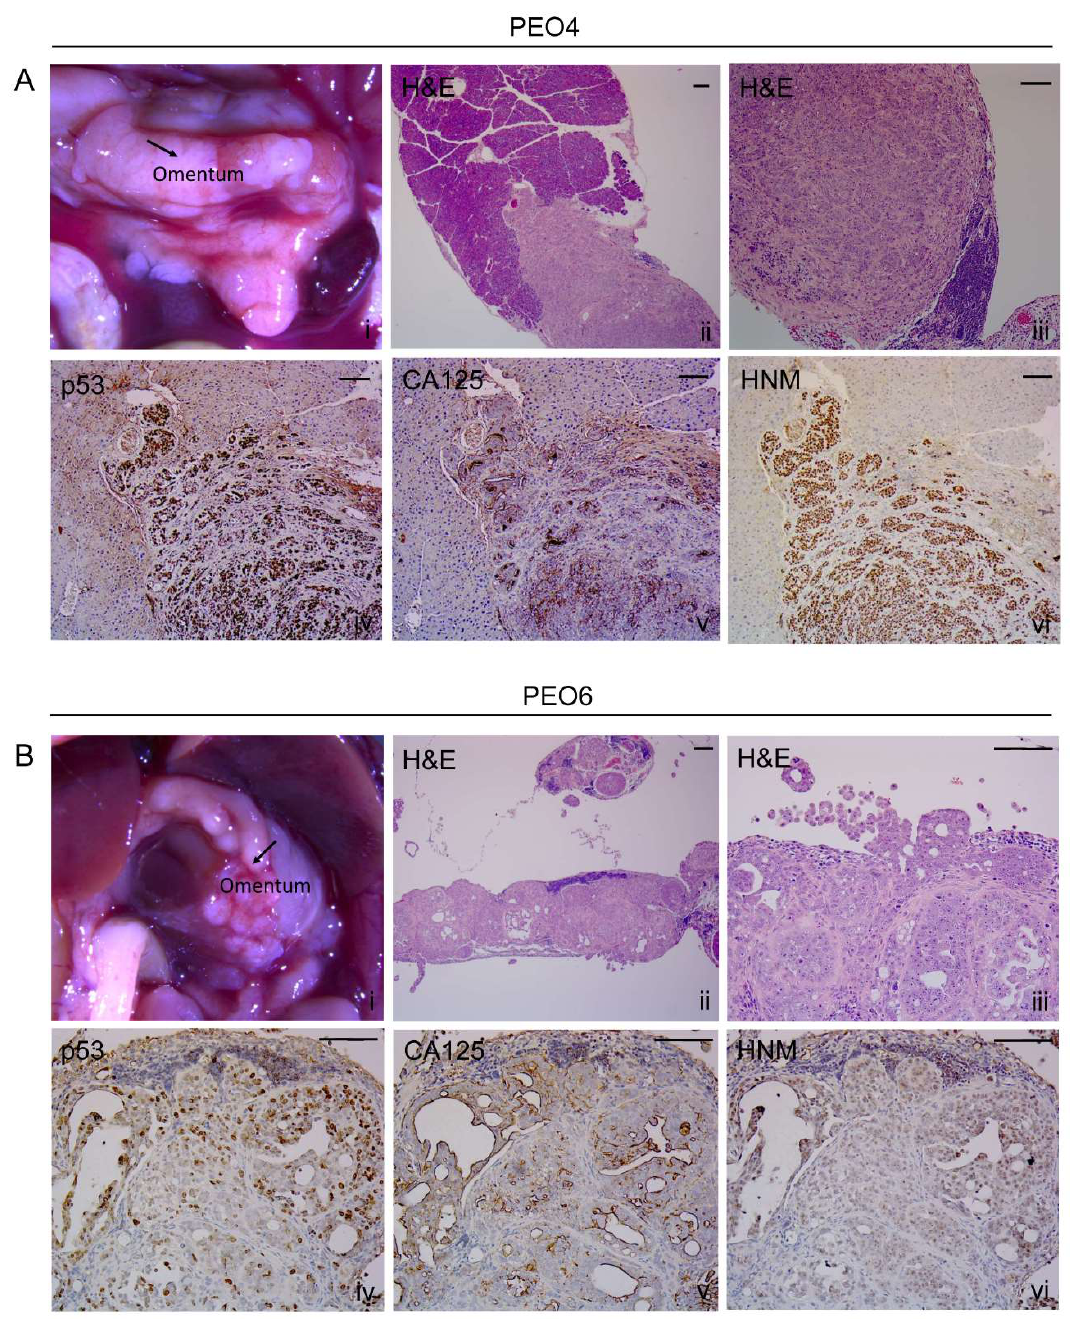
Figure 5. Metastases in the omental area. ( A ) PEO4 cells occupy the omentum and invade in the direction of the pancreas. Images show the positivity of the invasive metastases for p53, CA125, and HNM. Notice that the pattern of expression of cancer cells is very tight or solid. ( B ) Arrangement of PEO6 cells in the omental area depicts a micropapillary phenotype with multicellular structures accumulated toward the periphery of the tissue. Notice that the staining for p53 and HNM is more homogeneous than that of CA125, which is mostly expressed toward open tissue with pseudoglandular areas. Scale bars = 100 μm.